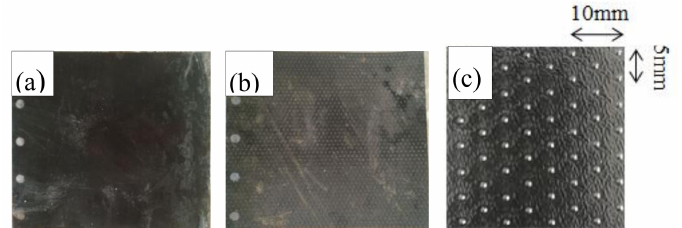
Figure 2. Physical aspect of the high-density polyethylene (HDPE) geomembrane with a ( a ) smooth and ( b ) rough surface; ( c ) the arrangement of bulges on the surface of rough